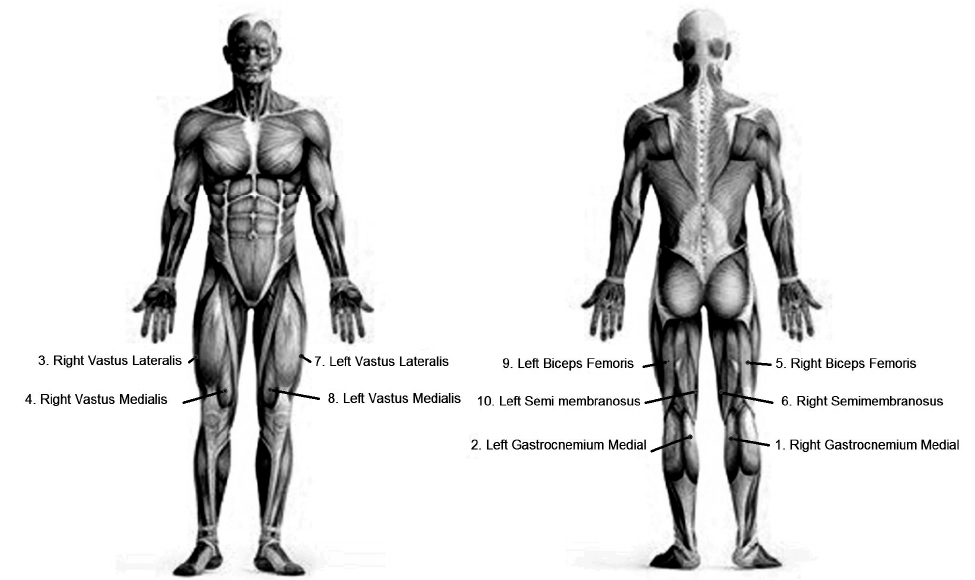
Figure 2. The sensor positions used for surface electromyography.